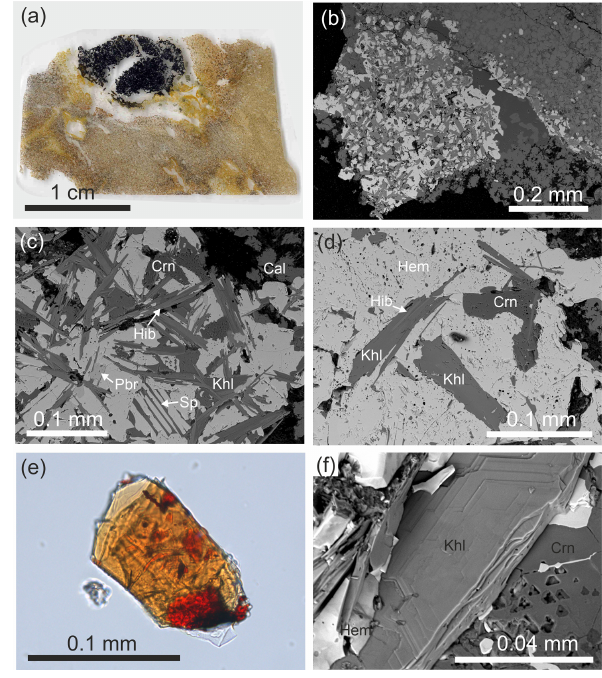
Figure 4. (a) Hematite segregation in wollastonite–gehlenite horn- fels with grey-green esseneite crystals around it; (b) hematite en- clave with a significant amount of hibonite, spinel, corundum, and dorrite; (c) hibonite overgrows and replaces kahlenbergite; (d) rare, relatively large kahlenbergite crystals in hematite; (e) kahlenbergite crystal flattened on (001) with epitaxial inclusions of hibonite (or- ange) and spinel inclusion (red); optical photo in immersion with n = 1 . 63; (f) fragment of flattened kahlenbergite crystal with hexag- onal elements of microrelief. Mineral symbols are hibonite (Hib), spinel (Sp), corundum (Crn), calcite (Cal), kahlenbergite (Khl), hematite (Hem), and pseudobrookite